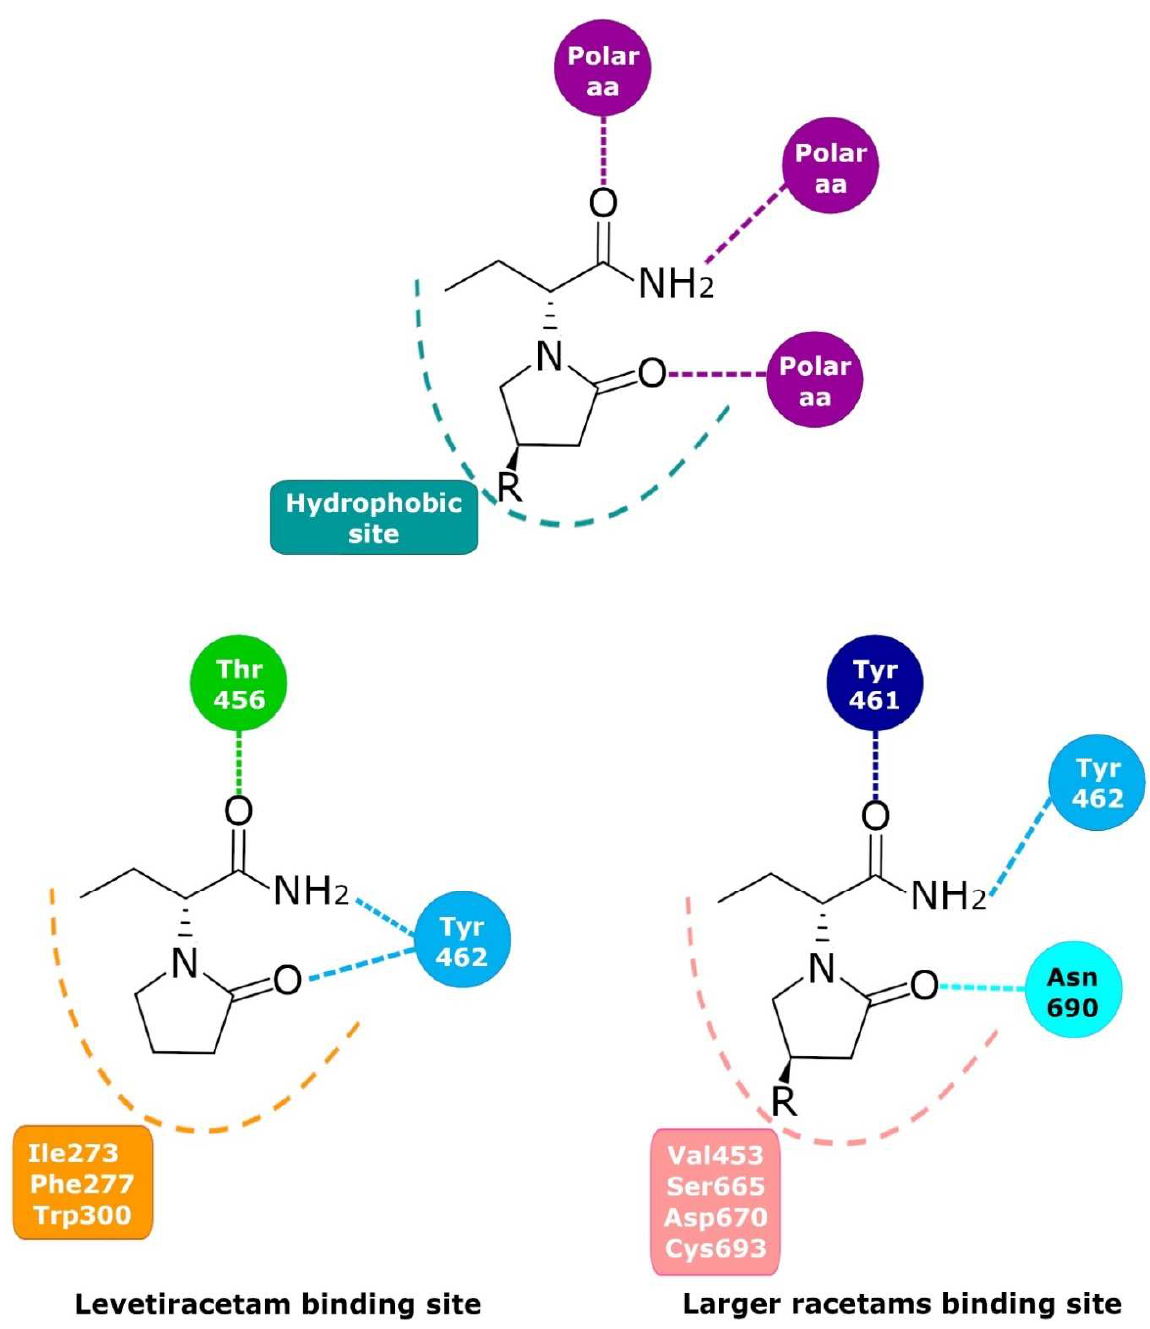
Figure 2. Schematic representation of the racetam binding site in SV2A found by molecular modeling. Despite having the same components, LEV binds differently than the rest of the racetams in a pocket in front of the racetam binding site that had some polar amino acids that can interact with polar groups in position 4, as in